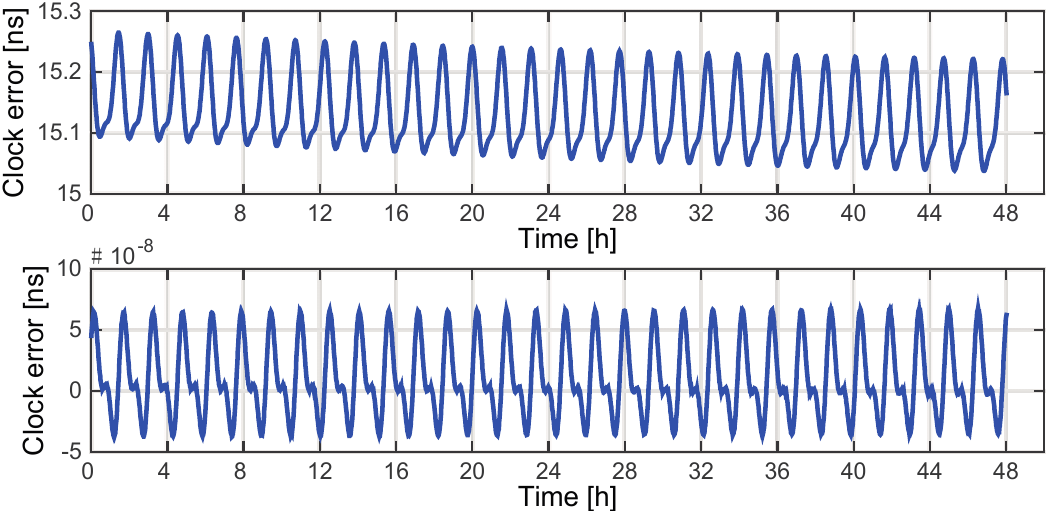
Figure 8. Decoupling clock error of GRACE 1 before (up) and after (down) motion compensation.